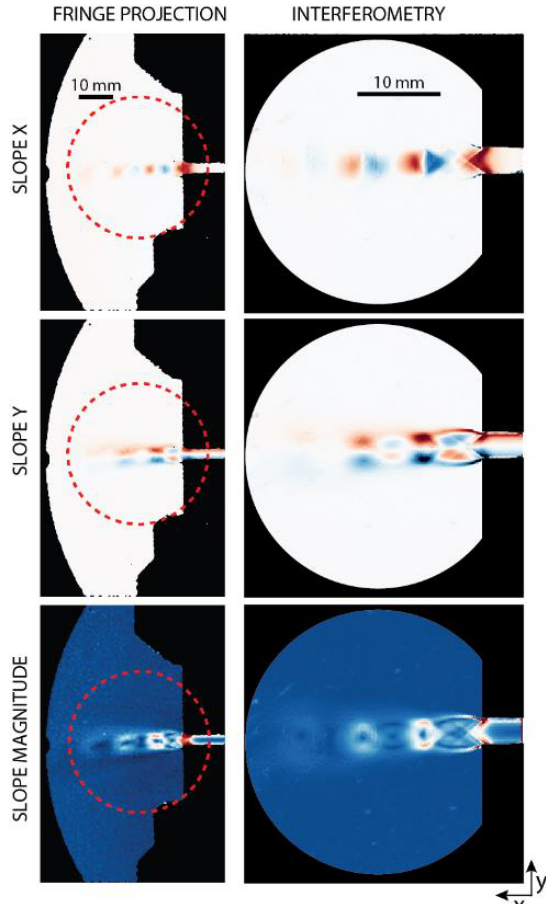
Fig. 6. Slope maps 𝑑𝑛/𝑑𝑥 , 𝑑𝑛/𝑑𝑦 and the magnitude of the gradient vector measured by the fringe projection technique and by interferometry. The red dashed circle indicates interferometer’s field of view.